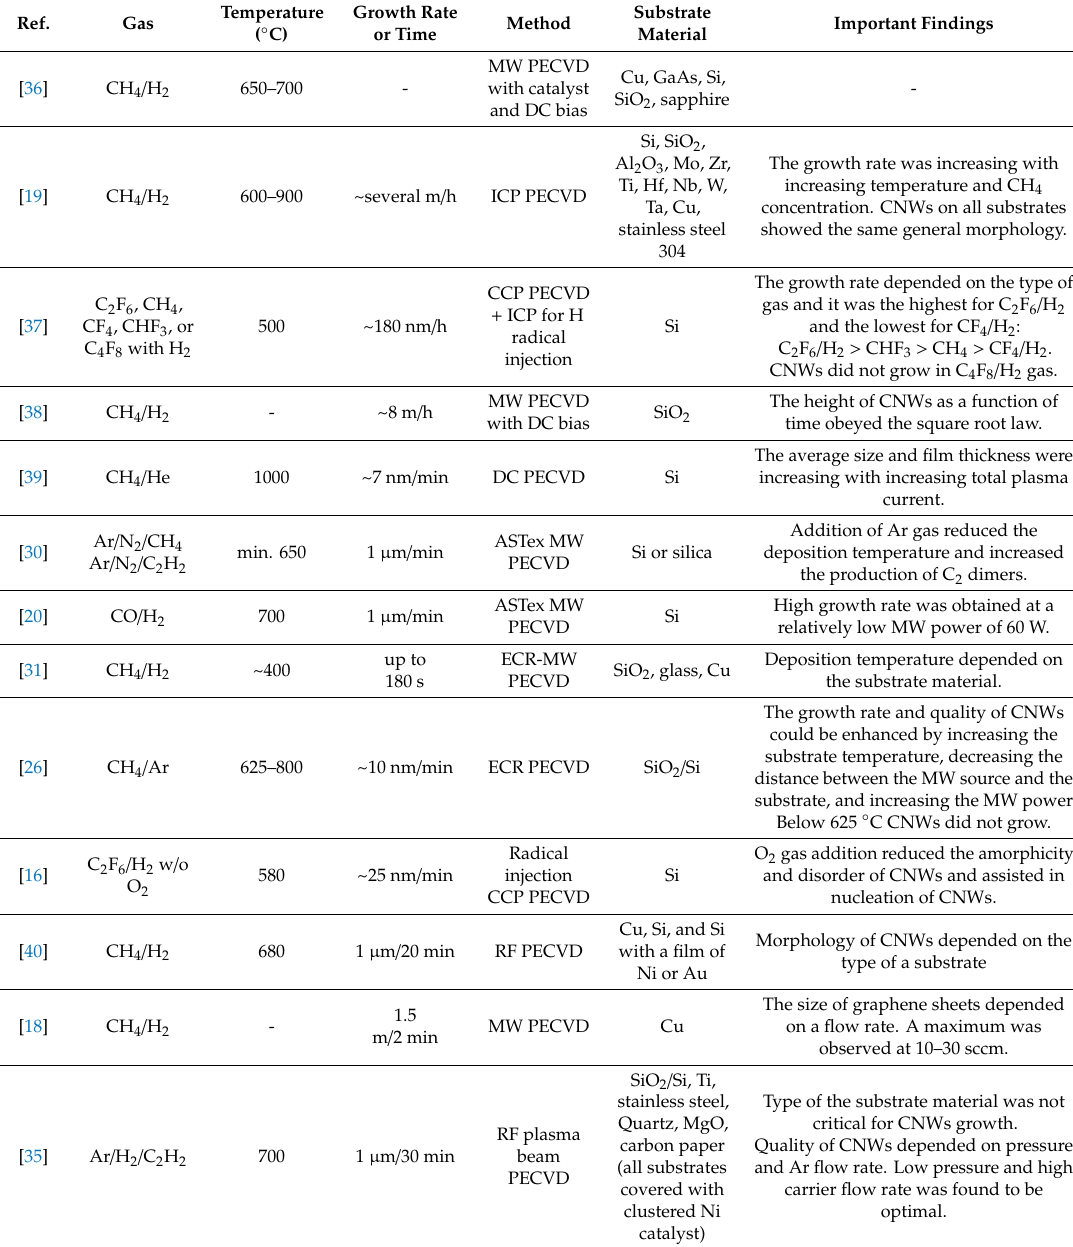
Table 1. Methods and conditions for CNWs